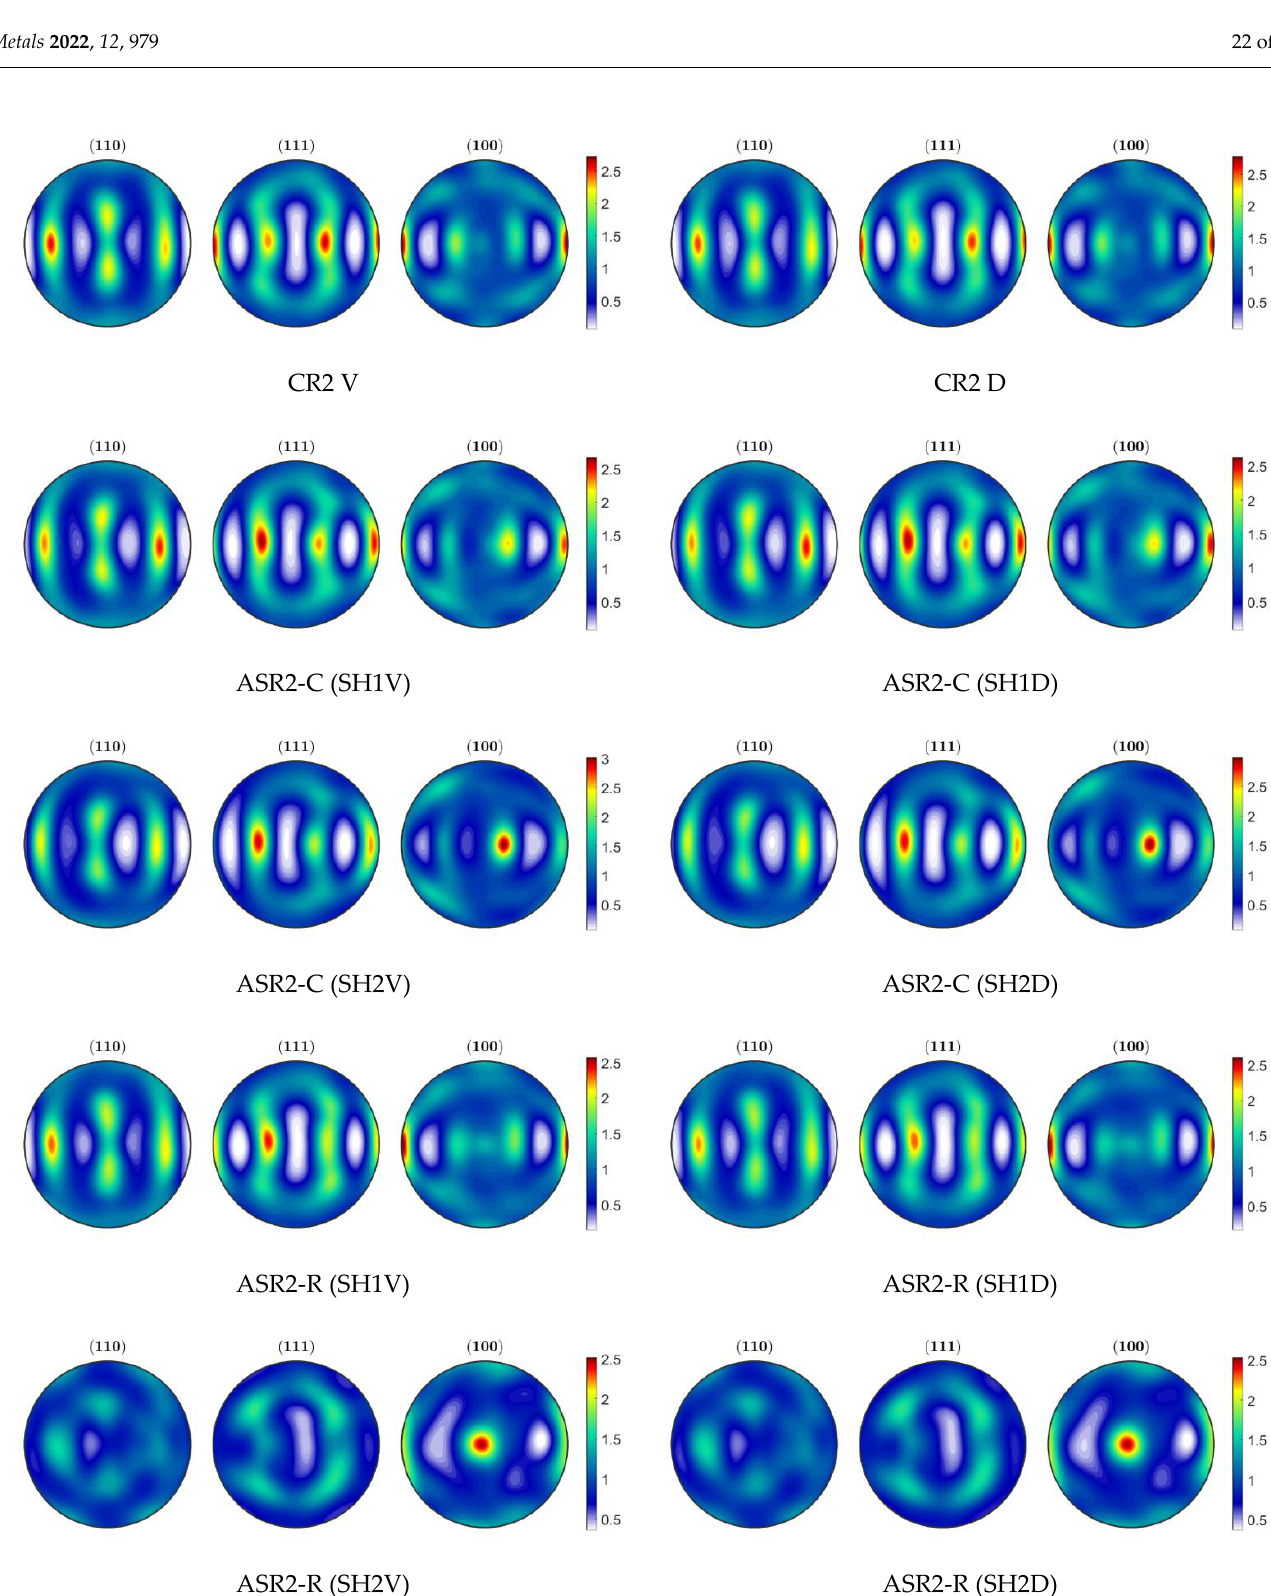
Figure A4. Pole figures for the second pass with a 20% thickness reduction per pass.